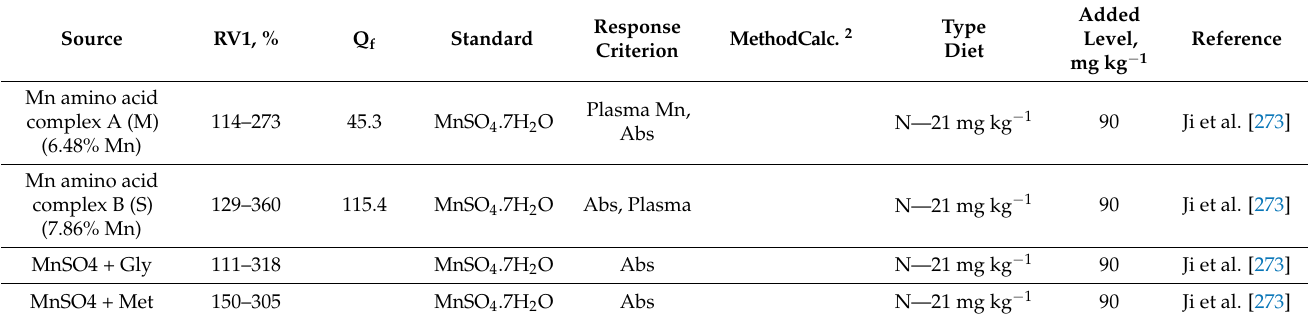
Table 8. Relative absorption values with published Q f values 1